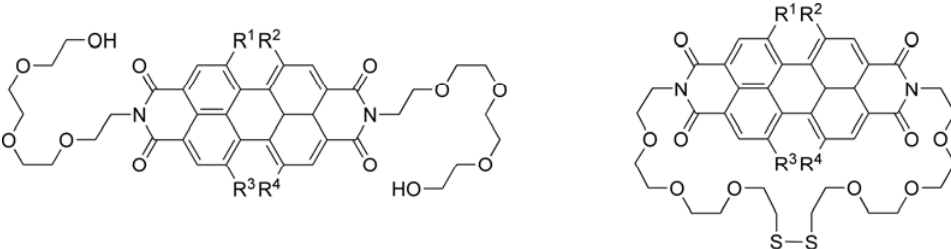
Figure 4. Perylene bisimide building